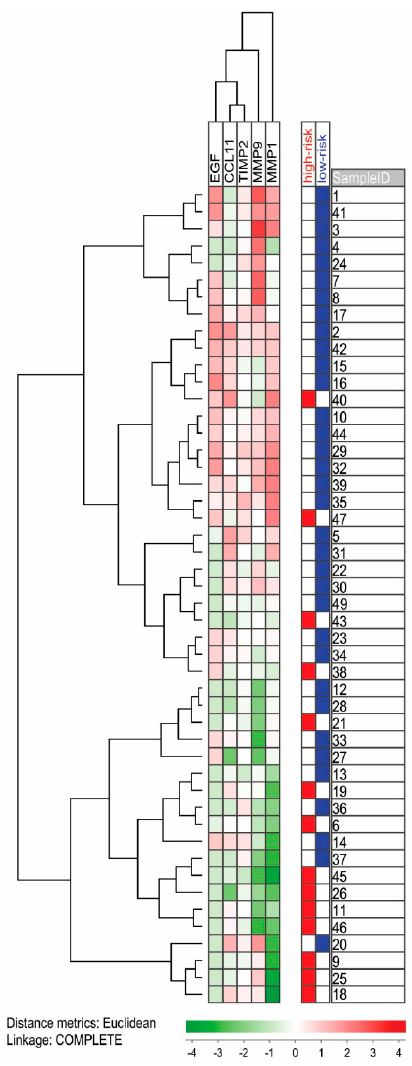
Figure 3. Unsupervised hierarchical clustering analysis of high- and low-risk MDS patients. The analysis was based on five mediators that showed statistically significant differences between the two MDS subsets; we excluded the three mediators CCL5, CXCL5, and CD40L that also showed significant differences but in addition showed significant correlations with platelet counts. All values were median variance standardized and log(2)-transformed prior to Euclidian distance clustering. Red-to-green gradient represents expression levels above or below the median serum levels for each individual parameter, respectively. Each row represents one individual, and low-risk MDS patients are marked with blue and high-risk MDS patients with red.